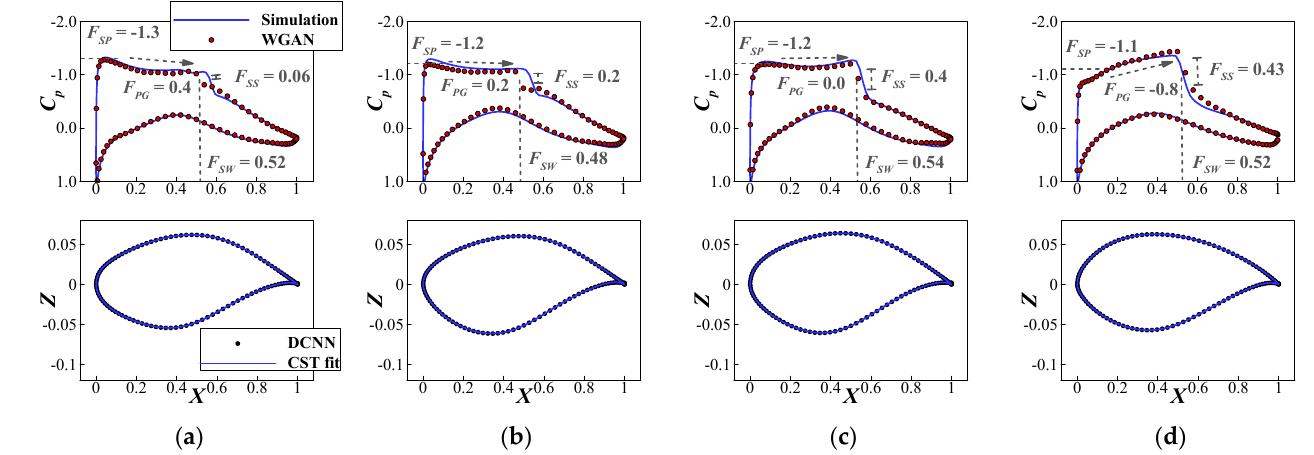
Figure 16. Typical inverse design results produced by different constraint combinations: ( a ) Design 1: c 1 = −1.3, c 2 = 0.4; ( b ) Design 2 : c 1 = −1.2, c 2 = 0.4; ( c ) Design 3 : c 1 = −1.2, c 2 = 0.0; ( d ) Design 4 : c 1 = −1.1, c 2 = 0.0.